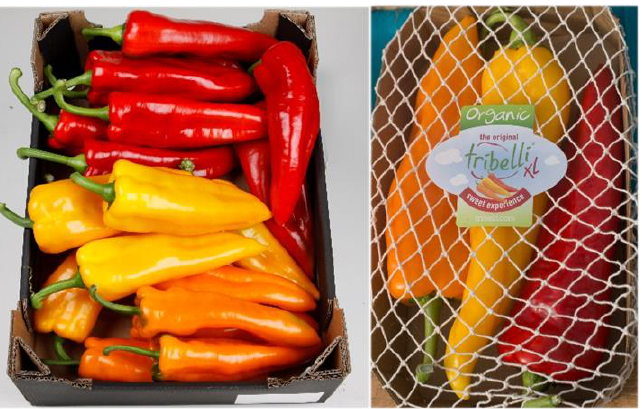
Figure 2. Fruits of the conical Tribelli XL ® pepper cultivars evaluated; ‘Xhanti’ cultivar (yellow fruit), Figure 2 . Fruits of the conical Tribelli XL® pepper cultivars evaluated; ‘ Xhanti ’ cultivar (yellow fruit), ‘43’ cultivar (red fruit), and ‘Spiker’ cultivar (orange fruit). ‘ 43 ’ cultivar (red fruit), and ‘ Spiker ’ cultivar (orange fruit). Table 1. Sampling for each crop cycle and month of evaluation and days in which the samples of each tomato, cucumber, and pepper cultivar were measured in the laboratory.